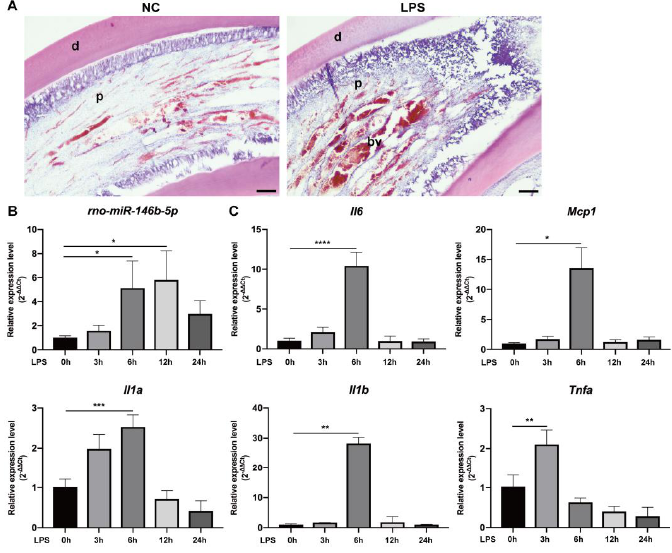
Figure 5. Expression of rno-miR-146b-5p and pro-inflammatory mediator mRNA is up-regulated in experimentally-induced rat pulpitis. ( A ) Typical inflammation reactions induced by LPS including vasodilatation and infiltration of inflammatory cells were observed in LPS-applied rat incisor pulp tissues (H&E). ( B ) Expression of rno-miR-146b-5p was significantly up-regulated in rat incisor pulp tissue at 6 h after LPS application and peaked at 12 h (mean ± SD, n = 3). ( C ) mRNA expression of pro-inflammatory mediators Il6 , Mcp1 , Il1a , Il1b , and Tnfa was induced by LPS stimulation and peaked at 6 h ( Tnfa peaked at 3 h; mean ± SD, n = 3). * p < 0.05, ** p < 0.01, *** p < 0.001, and **** p < 0.0001. LPS: lipopolysaccharide; d: dentin; p: pulp; bv: blood vessel; Scale bars: 150 μm.